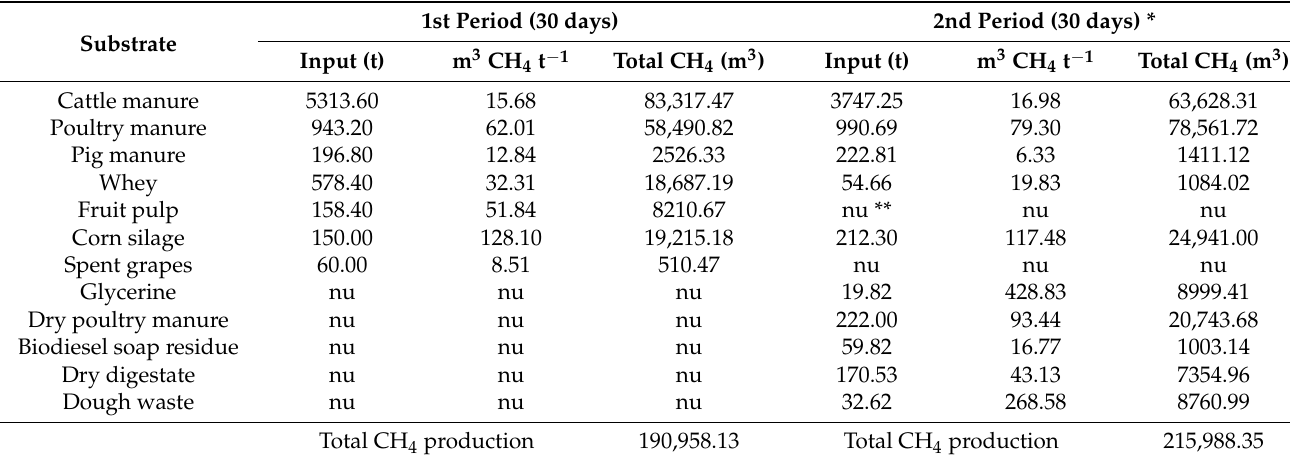
Table 2. Input quantities of each waste for the two periods under examination, their methane potential, and the calculated total methane production for each